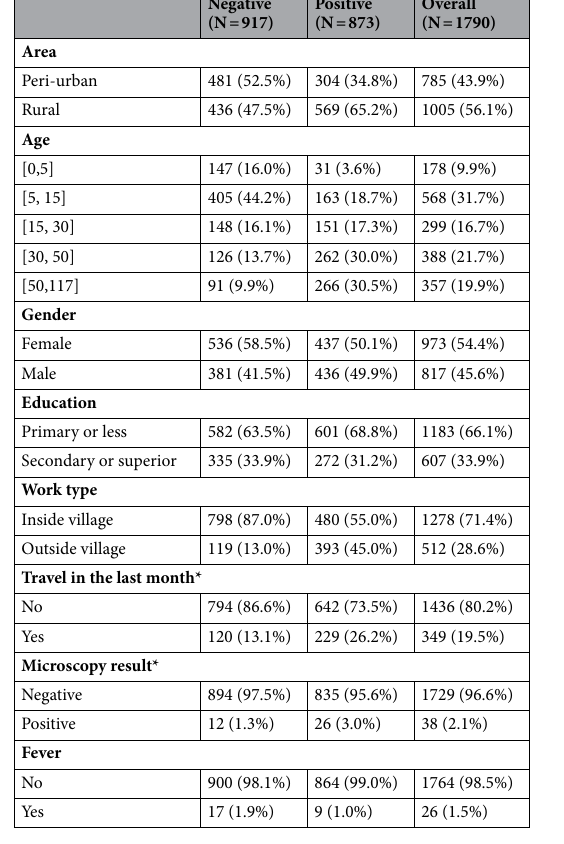
Table 1. Baseline characteristics of the study population and their malaria seropositive status. *variable with missing